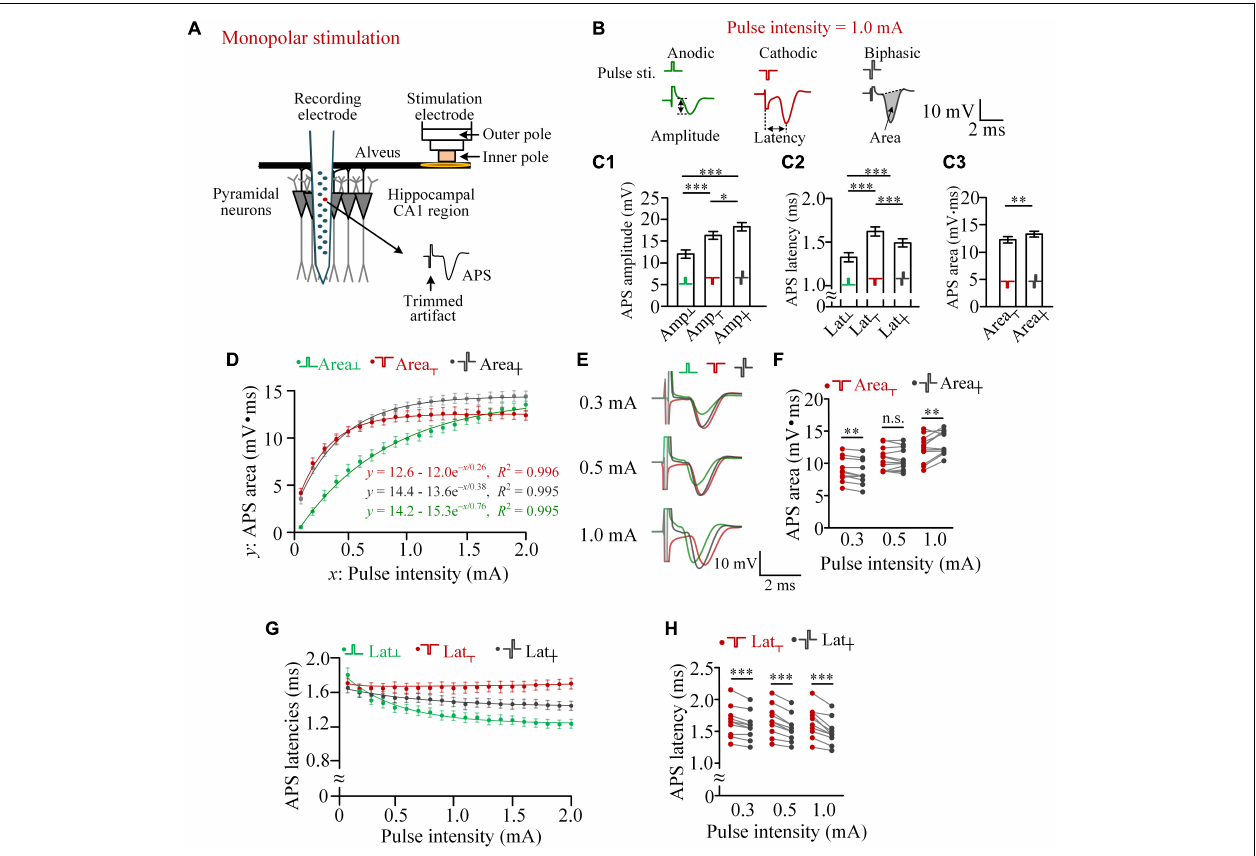
FIGURE 1 | Differences in the activation efficiencies of anodic, cathodic, and biphasic pulses in monopolar stimulations in rat hippocampal CA1 region. (A) Schematic diagram of the locations of recording and stimulation electrodes. (B) Examples of antidromically evoked population spike (APS) potential waveforms evoked by the three types of pulses with an identical pulse intensity of 1.0 mA, together with the definitions of APS amplitude, APS latency, and APS area. (C) C1 and C2: comparisons of the amplitudes and latencies of APS evoked by the three types of pulses with a pulse intensity of 1.0 mA ( ∗ p < 0.05, ∗∗∗ p < 0.001, two-way ANOVA, post hoc least significant difference test, n = 12). C3: comparisons of the areas of APS evoked by cathodic and biphasic pulses ( ∗∗ p < 0.01, paired t -test, n = 12). (D) Changes of mean APS areas evoked by the three types of pulses against the pulse intensity increasing from 0.1 to 2.0 mA with a step of 0.1 mA, together with exponential curve fitting. (E) Examples of superimposed APS waveforms evoked by the three types of pulses with pulse intensities of 0.3, 0.5, and 1.0 mA. (F) Comparisons of areas of APS evoked by cathodic and biphasic pulses with pulse intensities of 0.3, 0.5, and 1.0 mA ( ∗∗ p < 0.01; n.s., not significant, paired t -test; n = 12). (G) Changes of mean APS latencies evoked by the three types of pulses against the pulse intensity. (H) Comparisons of latencies of APS evoked by cathodic and biphasic pulses with pulse intensities of 0.3, 0.5, and 1.0 mA ( ∗∗∗ p < 0.001, paired t -test, n =